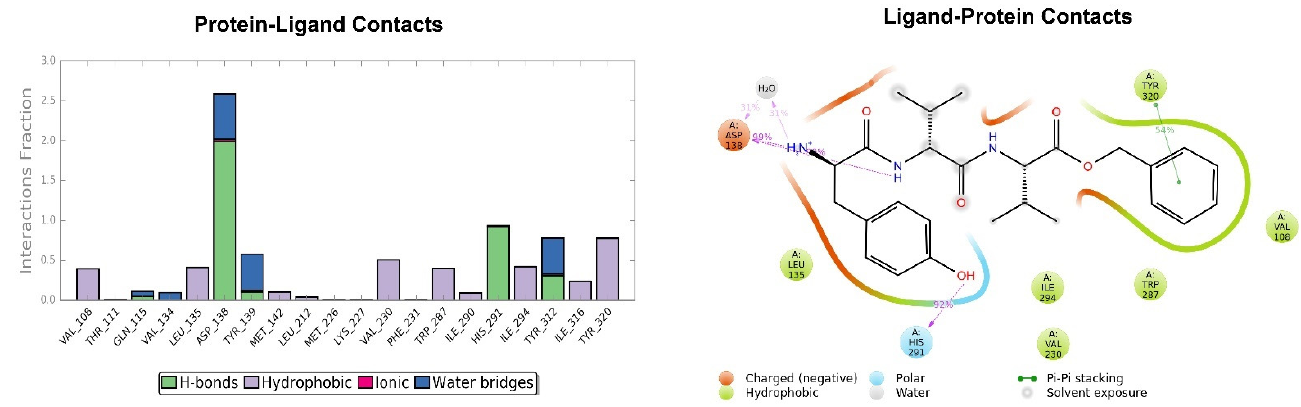
Figure 12. Interactions of H-D-Tyr-D-Val-Val-OBz within the KOR binding pocket, expressed in %. Hydrogen bonds are in violet lines.